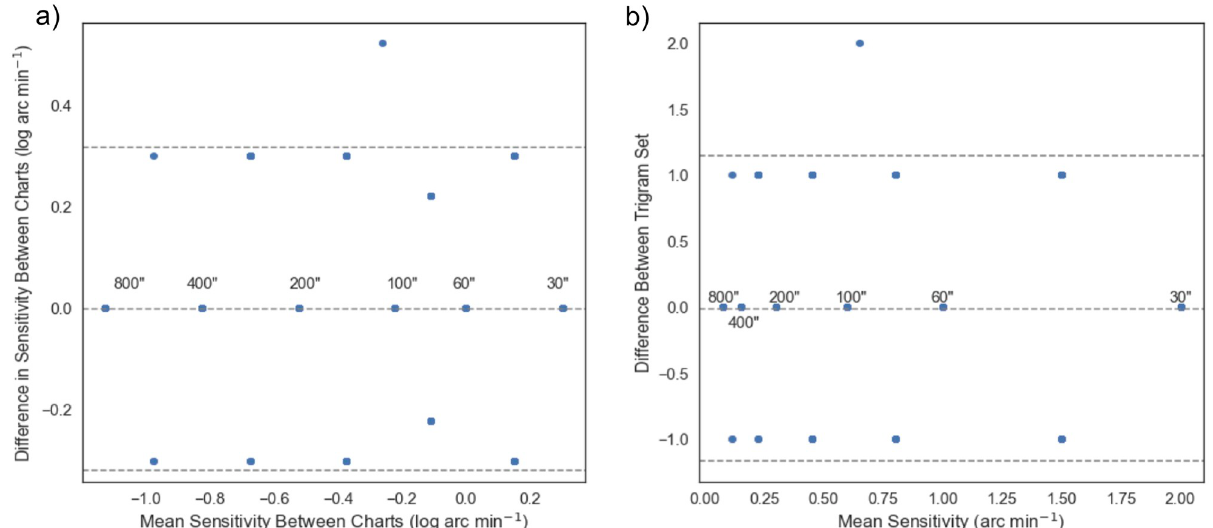
Fig 4. Bland-Altman plot for test-retest repeatability between the two versions of charts. a) Most results are within a 95% confidence interval, denoted by the horizontal dashed lines. Note that the units used in x and y abscissa are in log value. For easier reference, the values in arcsecs are labeled next to the points. The two charts have good test-retest repeatability. b) To test on the repeatability within neighboring trigram set, we transformed the result, in arc minutes, into trigrams sequence, 1 to 8 (1600 arc secs for 1 and 8 for 30 arc secs). The test-retest repeatability is within 1 set of trigrams between the two charts. In other words, the individual’s performance was in the range of one neighboring set of trigrams between the two trials. Note that the units here are in linear scale.